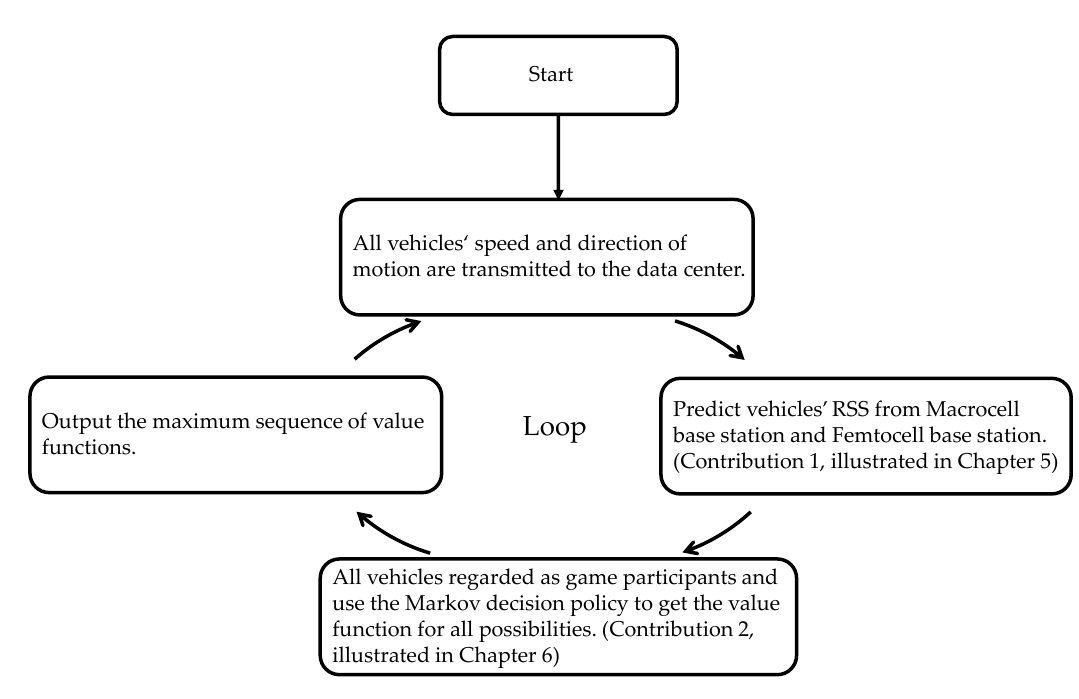
Figure 3. Workflow of the Markov decision